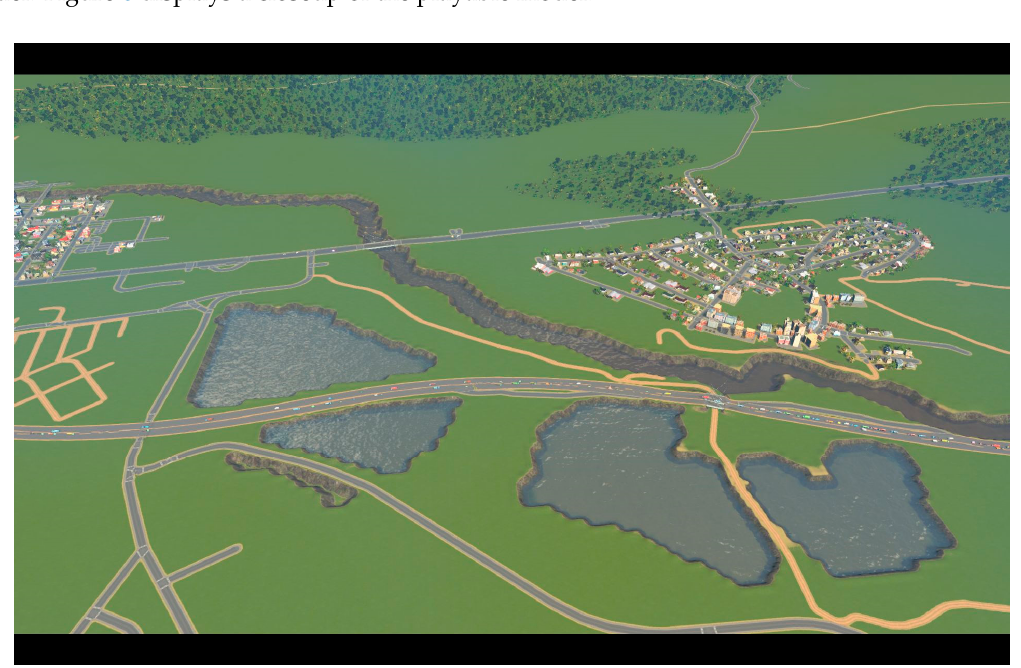
Figure 5. Overview of the resulting playable model of Svit after manual post-processing of the base model.